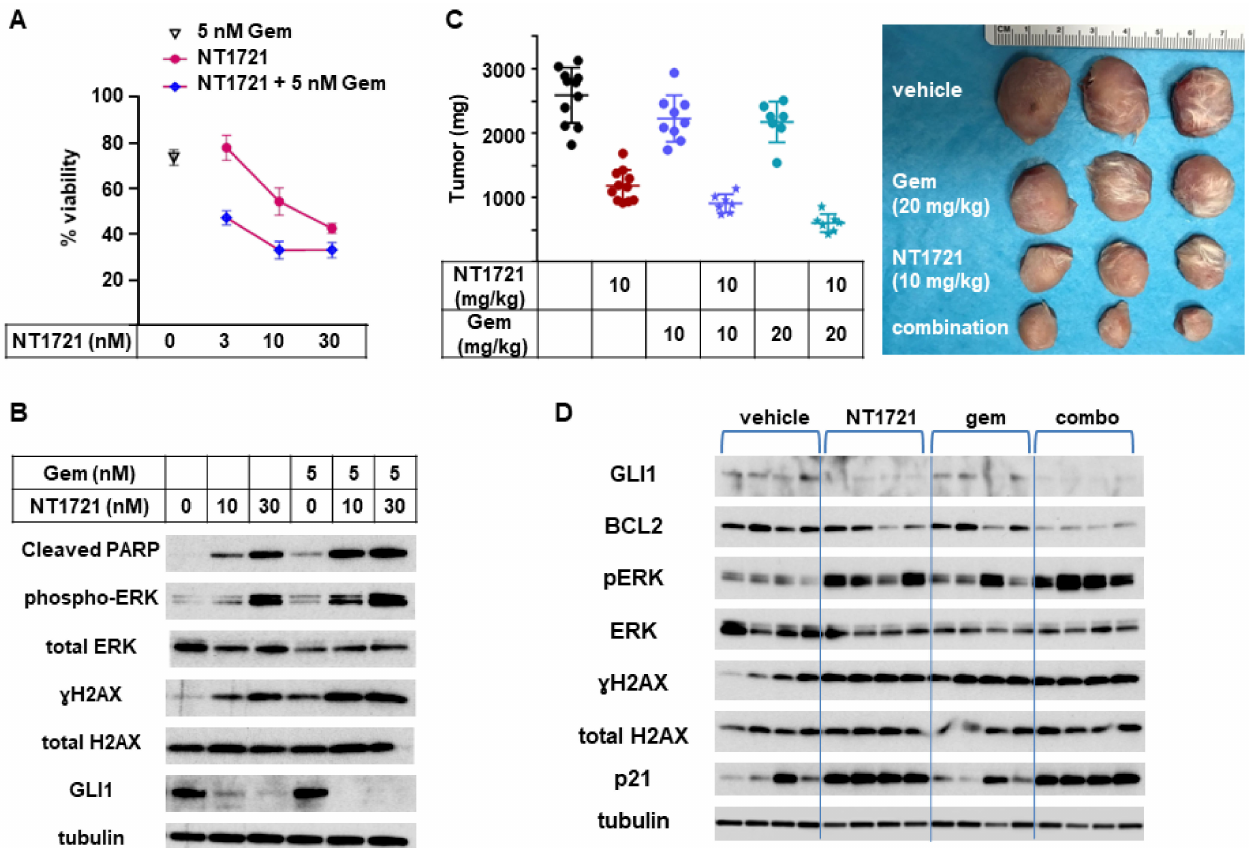
Figure 6. In vivo combination of NT1721 with gemcitabine. ( A ) Cell viability of HuT78 cells treated with NT1721, gemcitabine or a combination of the two drugs. ( B ) Protein expression of GLI1 and proteins related to apoptosis iHut78 H. Induction (cleaved PARP, pERK, γ H2A.x) in HuT78 cells treated with NT1721, gemcitabine or a combination of the two drugs for 48 h. ( C ) Tumor weight in mice treated with NT1721, gemcitabine, a combination of the two drugs with the vehicle controls (Ora-Blend containing 10% saline or PBS, respectively) for 3 weeks. Representative HuT78 tumors treated with the single drugs or drug combinations are shown on the right side. ( D ) Expression of GLI1 and proteins related to apoptosis iHut78 H. Induction (BCL2, p21, pERK, γ H2AX) in individual mice treated with 10 mg/kg NT1721, 20 mg/kg gemcitabine or the drug combination for 3 weeks. Original Western Blots of Figure 6B,D available in Figure